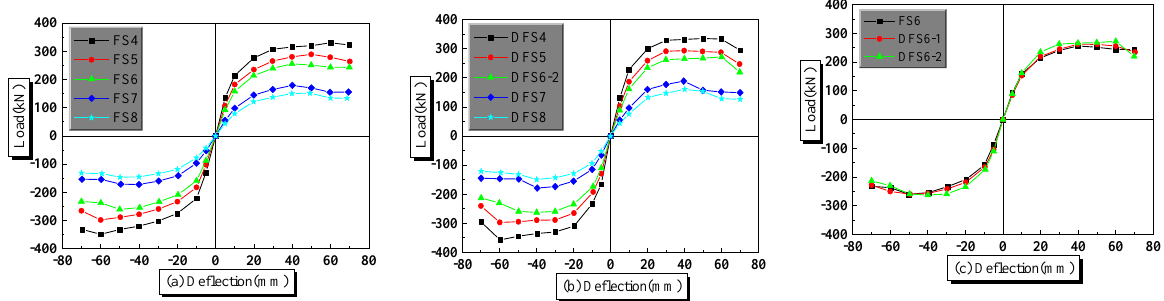
Figure 11. Skeleton curves for PPSRC joints e: ( a ) models FS4, FS5, FS6, FS7 and FS8; ( b ) models DFS4, DFS5, DFS6-2, DFS7 and DFS8; ( c ) models FS6, DFS6-1 and DFS6-2.